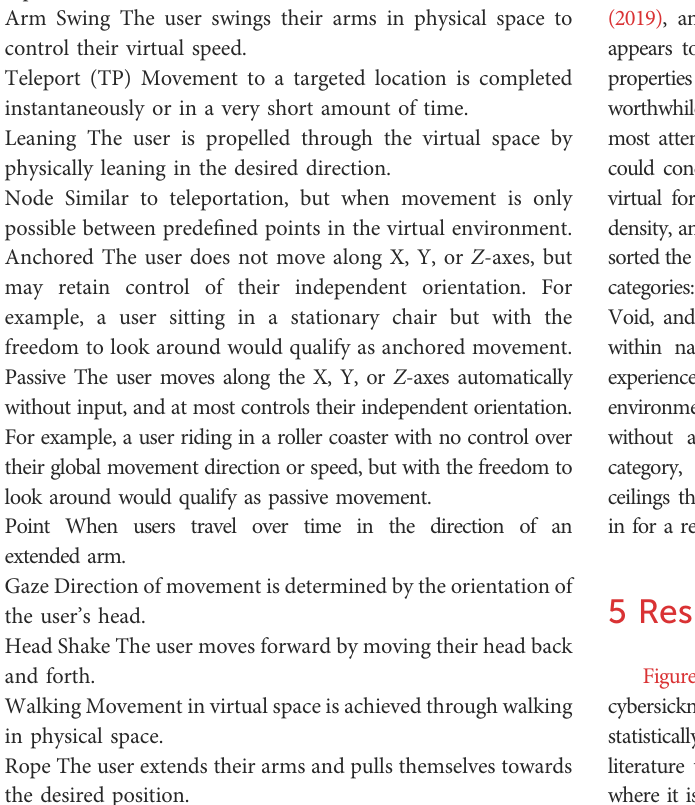
(cid:129) Steering The user travels in a direction over time based on the input or orientation of a controller device. (cid:129) Arm Swing The user swings their arms in physical space to control their virtual speed. (cid:129) Teleport (TP) Movement to a targeted location is completed instantaneously or in a very short amount of time. (cid:129) Leaning The user is propelled through the virtual space by physically leaning in the desired direction. (cid:129) Node Similar to teleportation, but when movement is only possible between prede fi ned points in the virtual environment. (cid:129) Anchored The user does not move along X, Y, or Z -axes, but may retain control of their independent orientation. For example, a user sitting in a stationary chair but with the freedom to look around would qualify as anchored movement. (cid:129) Passive The user moves along the X, Y, or Z -axes automatically without input, and at most controls their independent orientation. For example, a user riding in a roller coaster with no control over their global movement direction or speed, but with the freedom to look around would qualify as passive movement. (cid:129) Point When users travel over time in the direction of an extended arm. (cid:129) Gaze Direction of movement is determined by the orientation of the user ’ s head. (cid:129) Head Shake The user moves forward by moving their head back and forth. (cid:129) Walking Movement in virtual space is achieved through walking in physical space. (cid:129) Rope The user extends their arms and pulls themselves towards the desired position.